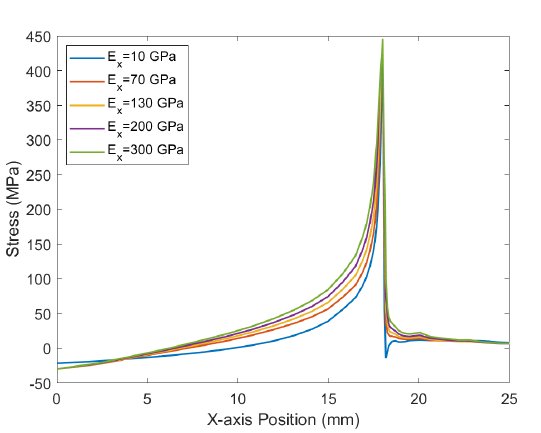
Figure 13. Stress profiles for various values of elastic properties.